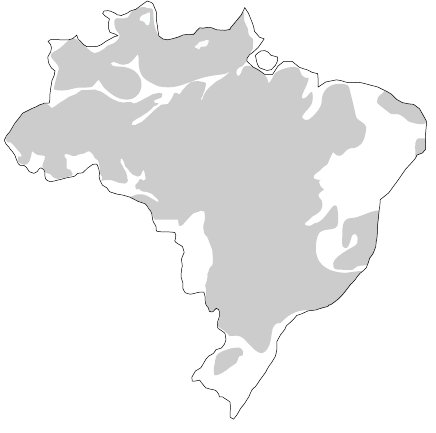
Fig. 4 – Area of lateritic cover (laterite and latosols) in Brazil (Melfi and Pedro 1977).